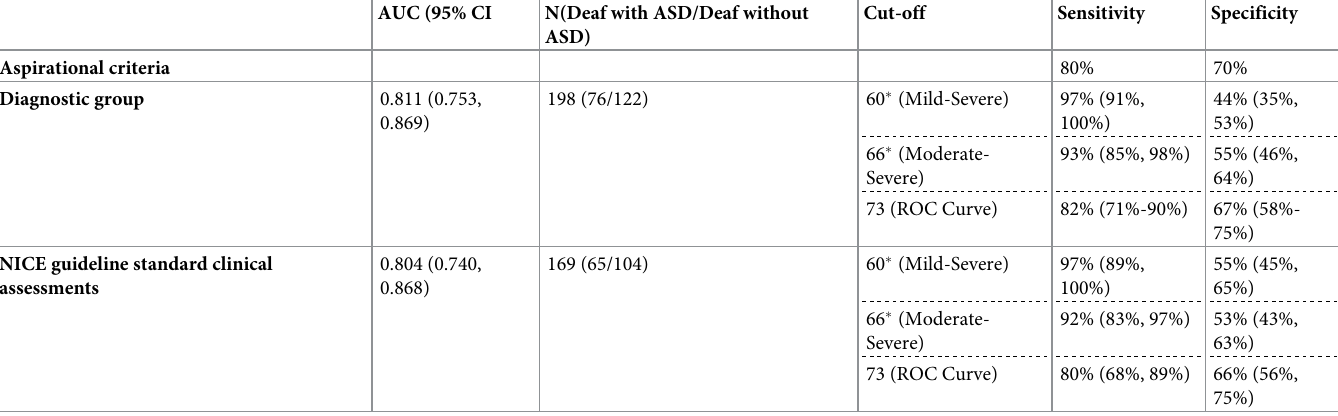
Table 5. ROC curve findings against the diagnostic group and NICE guideline standard clinical assessments.